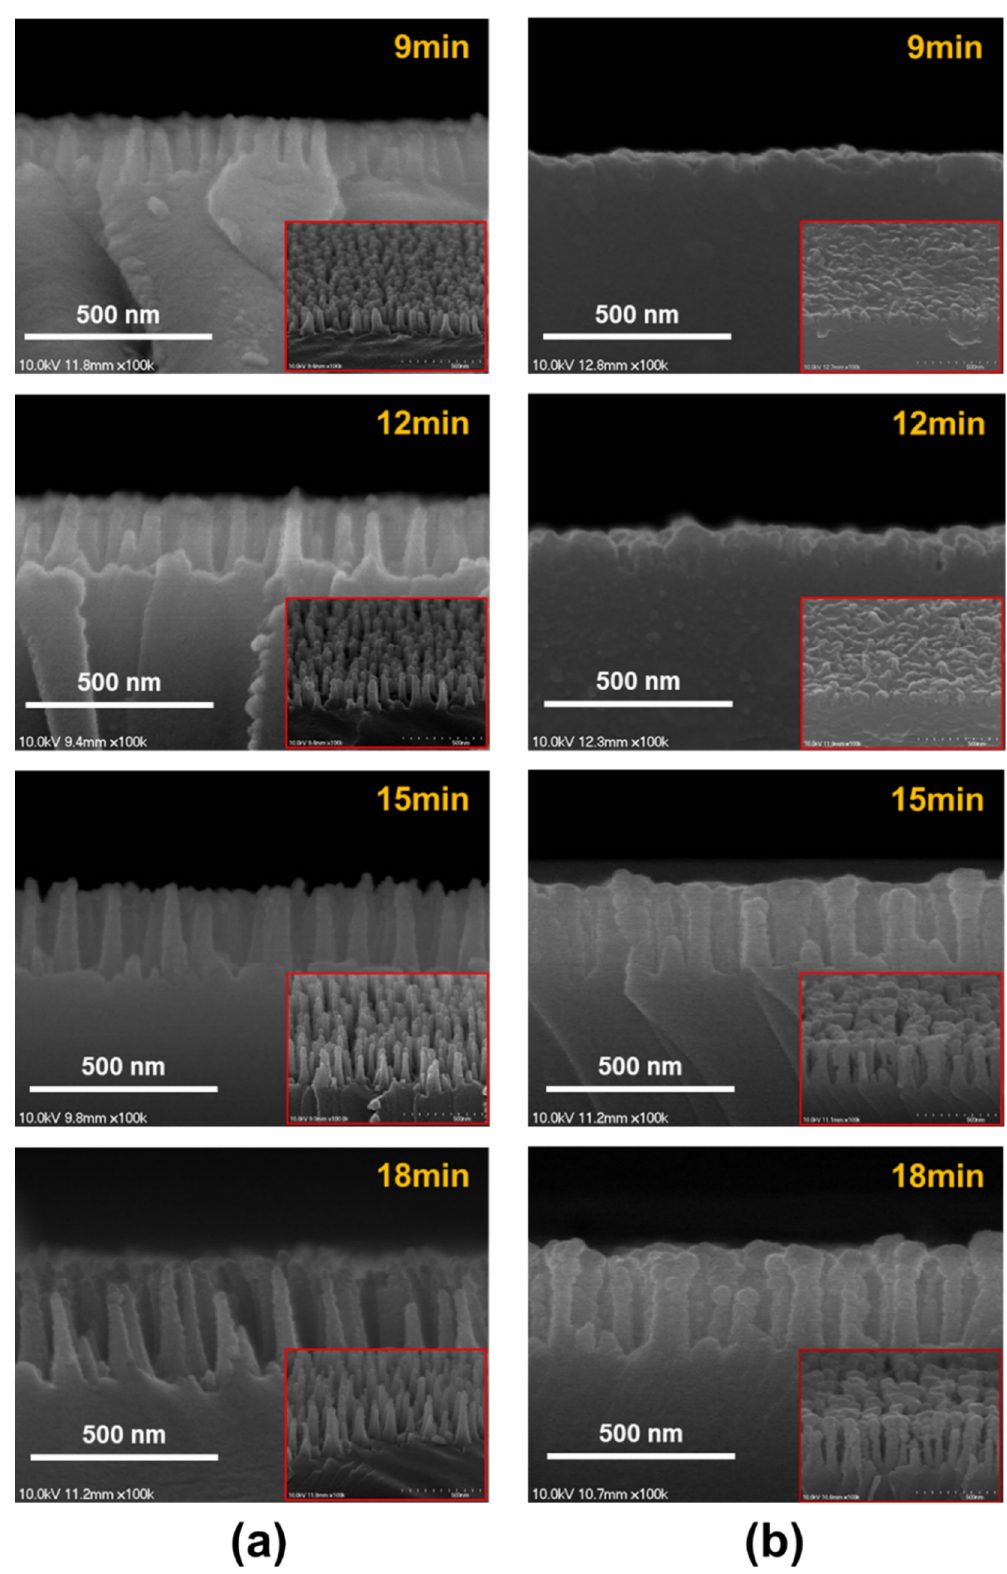
Figure 3. SEM images of the subwavelength structure (SWS)-integrated cover glass fabricated by ( a ) dry etching using the Ag nanoparticles and ( b ) one-step self-masked etching with various etching times.